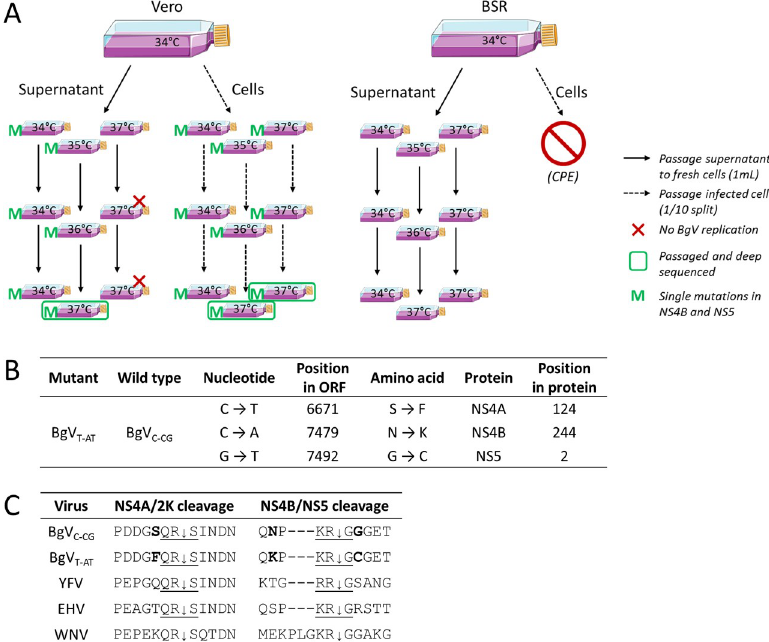
Fig 3. A. Blind passages of BgV in vertebrate cells. Flasks of BSR and Vero cells were inoculated with BgV at MOI 1 and incubated at 34˚C for five days. 1mL aliquots of supernatant from these flasks were blindly passaged three times to flasks of freshly seeded cells. Vero cells were split 1/10 and passaged three times, while BSR cells succumbed to cytopathic effect and could not be passaged. At each passage, one set of supernatant and cells was maintained at either 34˚C or 37˚C, while the third set was incubated at increasing temperatures: 35˚C, 36˚C and finally 37˚C. The presence of BgV in the harvested supernatants was tested by titration on C6/36 cells followed by fixed-cell ELISA. The red crosses represent samples in which BgV was not detected. Three samples were selected for further passaging (circled) and RNA extracts from the resulting supernatants were deep sequenced. The samples marked with a green M carried two of three identified conserved mutations, as determined by Sanger sequencing, in NS4B and NS5. B. The three conserved mutations identified by next-generation sequencing in replication-competent BgV variants. The nomenclature adopted hereafter is BgV C-CG for prototype BgV and BgV T-AT for a BgV variant containing all three NS4A/NS4B/NS5 identified conserved mutations. C. Alignment of selected flaviviruses over two viral protease cleavage sites: NS4A/2K and NS4B/NS5. The bolded letters correspond to the identified mutation sites in BgV sequence. The underlined letters and downward arrow correspond to the viral protease cleavage site.